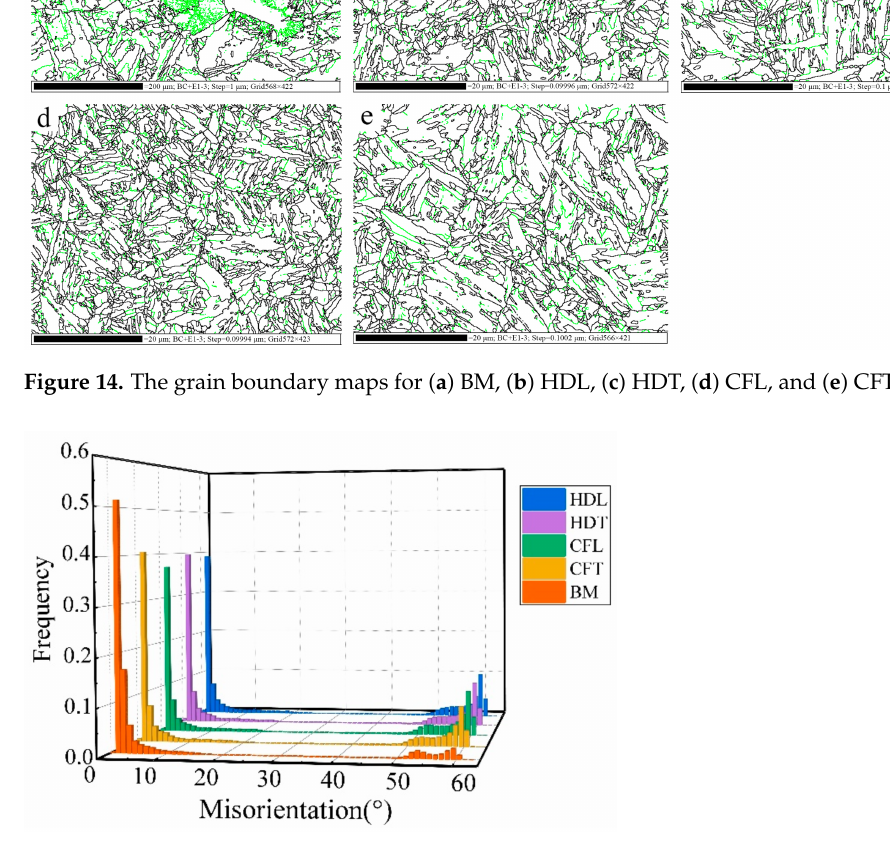
Figure 15. The misorientation distributions of grain boundaries of BM, HDL, HDT, CFL, and